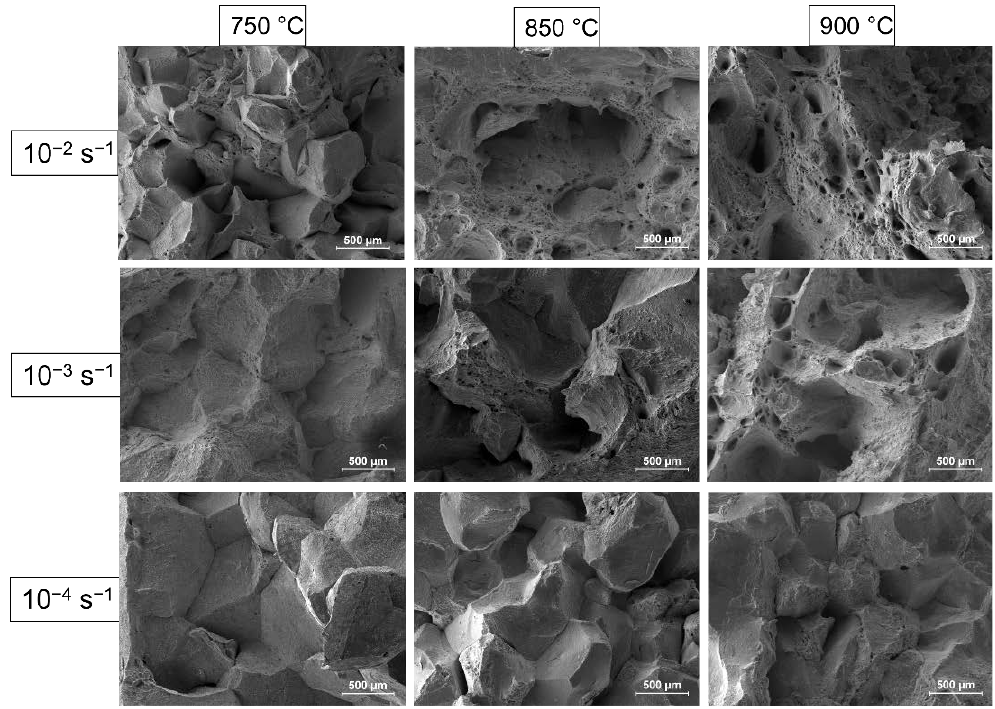
Figure 3. Fracture surfaces of steel A samples tested at different temperatures and strain rates.